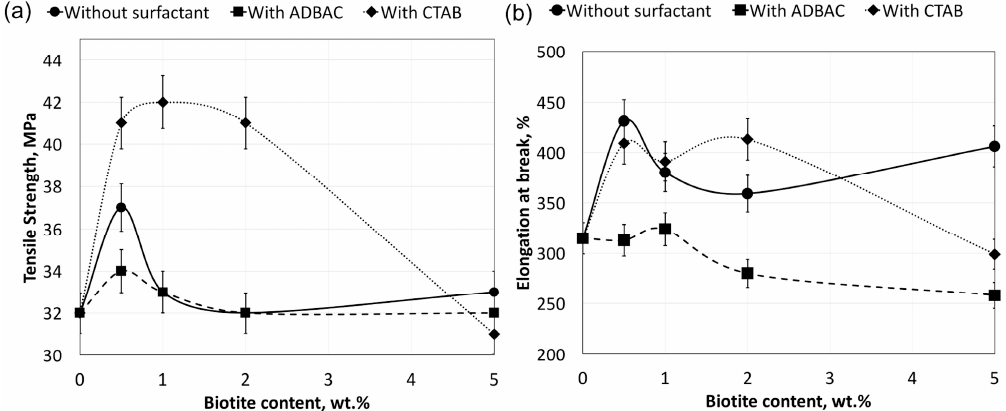
Figure 2. Mechanical properties of the polymer composites: tensile strength ( a ) and elongation at break ( b ). CTAB: cetyltrimethylammonium bromide; ADBAC: alkyldimethylbenzylammonium chloride.